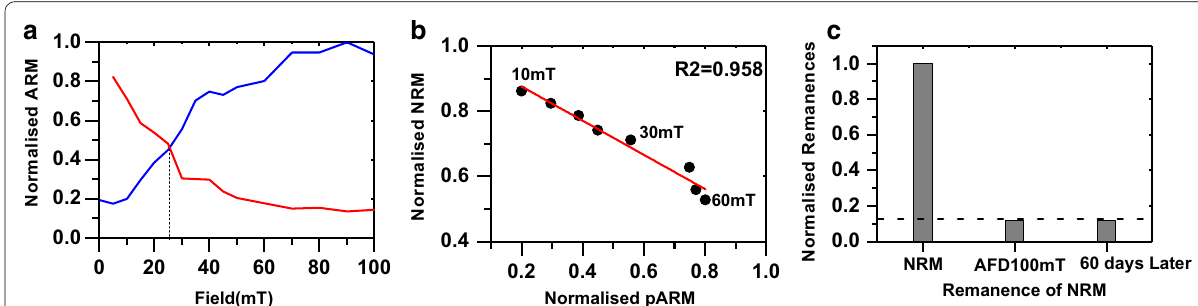
Fig. 7 a Alternating filed demagnetization (AFD) of normalized NRM (red curve) and acquired pARM (blue curve). b Remaining NRM and acquired ARM at the same applied field. c AFD remanences of the NRM and the variation of remanence over time